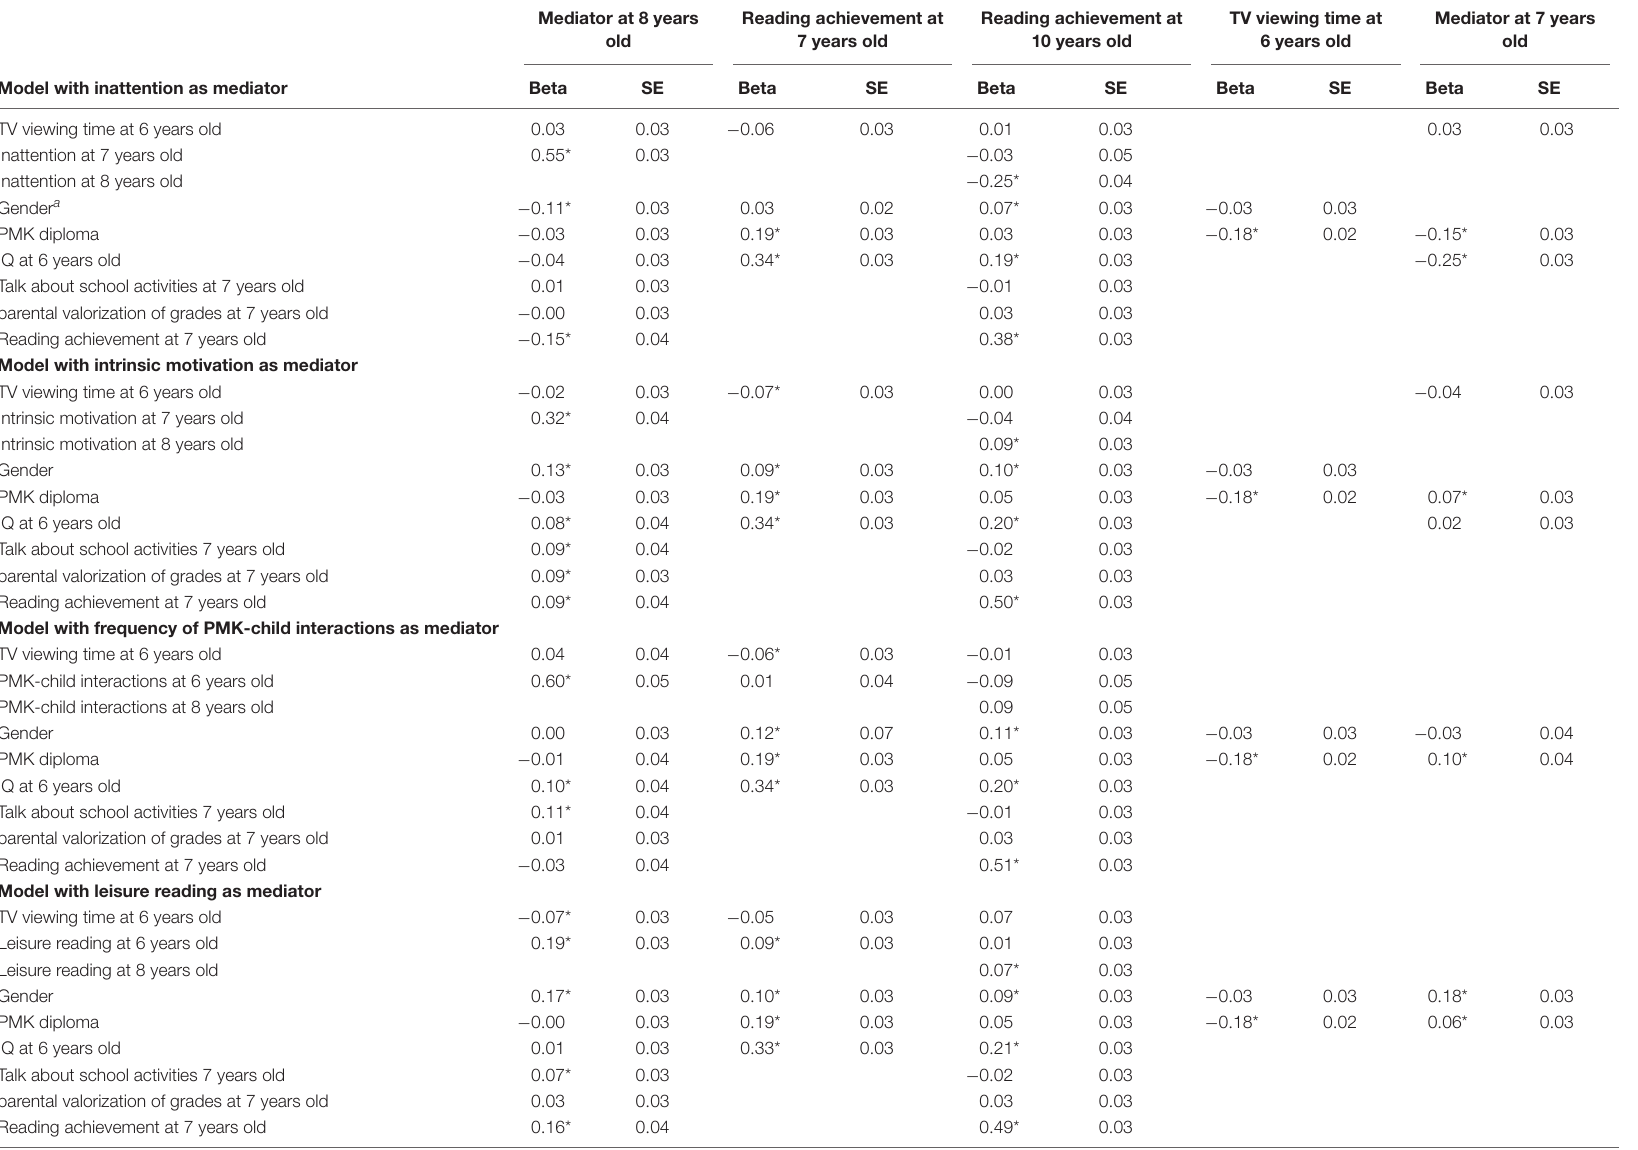
*indicates a p-value less than 5%. a 0 = boy and 1 =